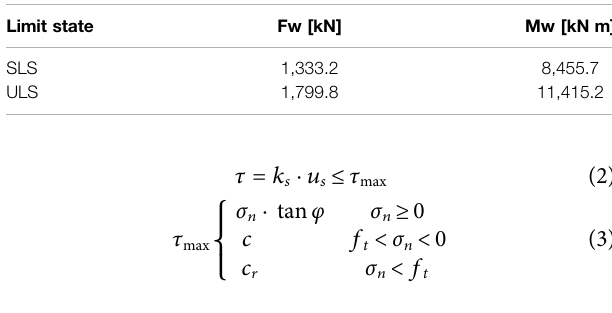
TABLE 3 | Wave loads with partial safety